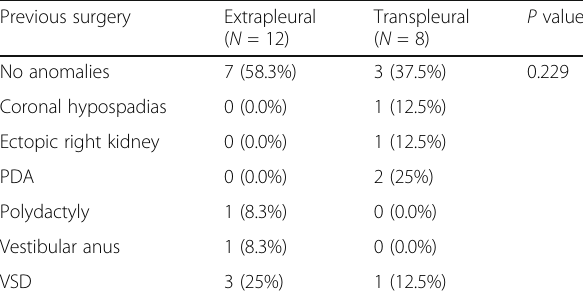
Table 2 Comparison between the groups regarding associated anomalies Previous surgery